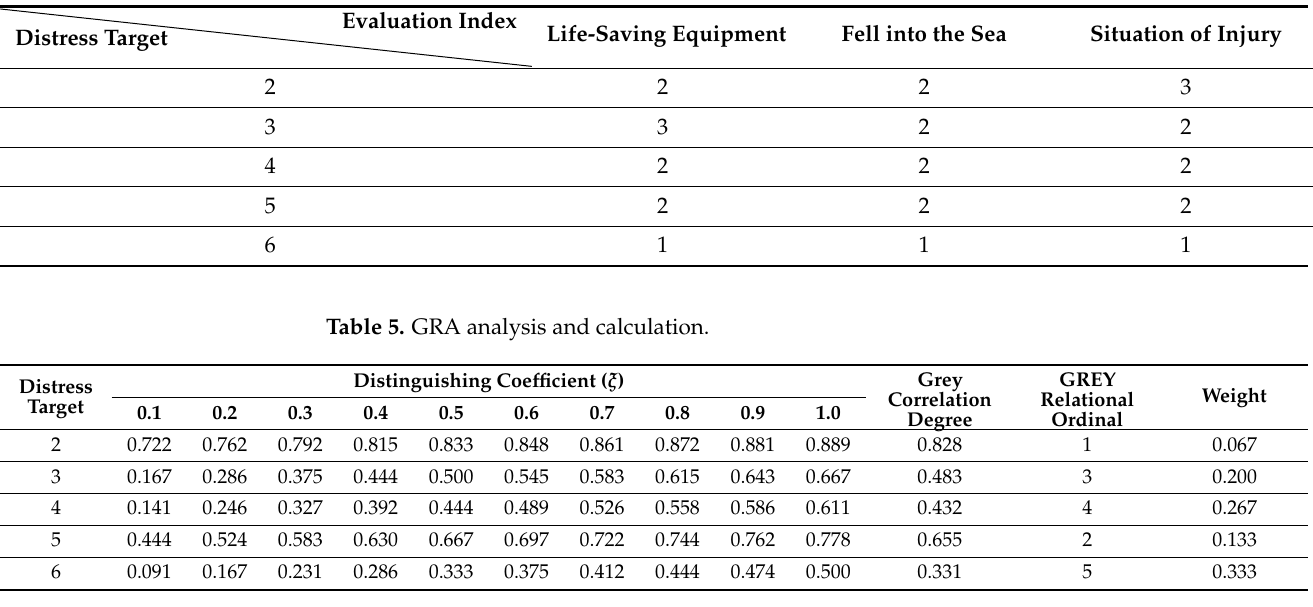
Table 4. Arrangement of Grey correlation matrix of marine distress situation.